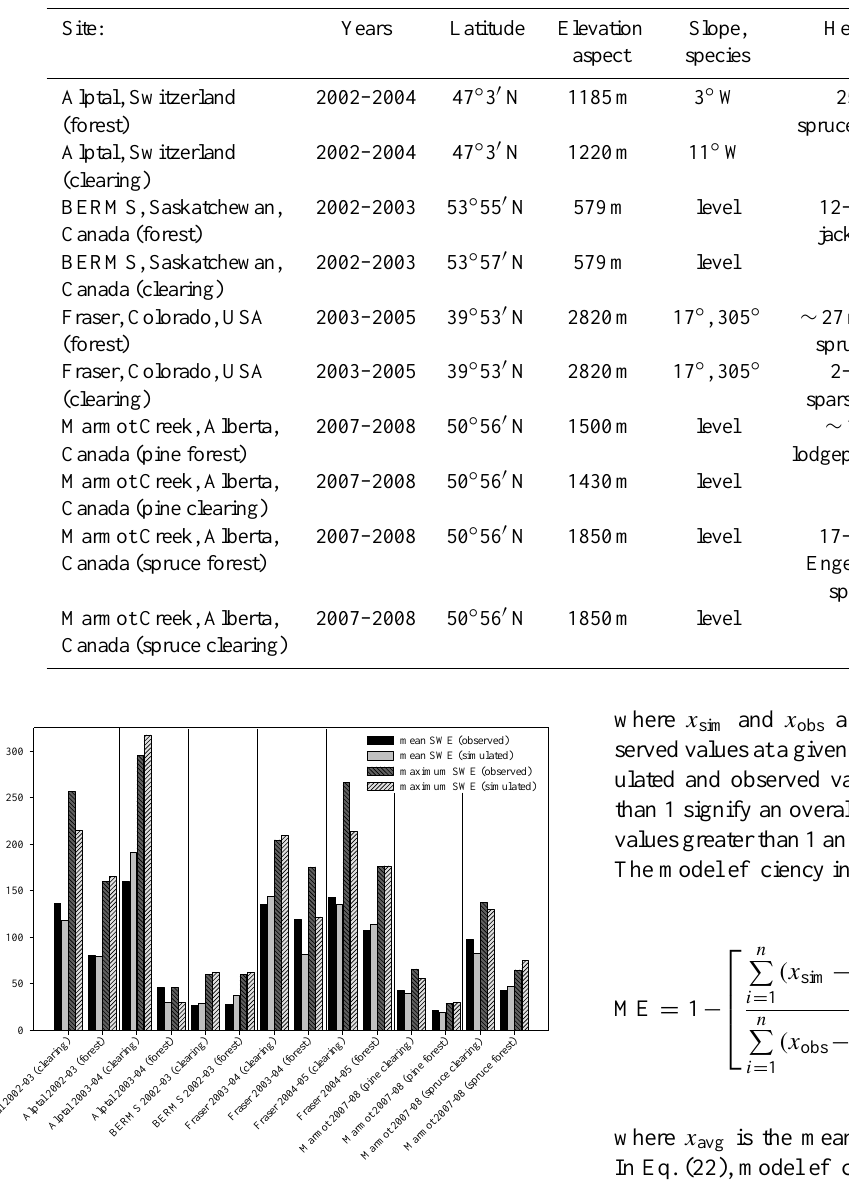
Figure 3. Fig. 3. Observed and simulated mean and maximum snow water equivalent (SWE) accumulations at forest and clearing